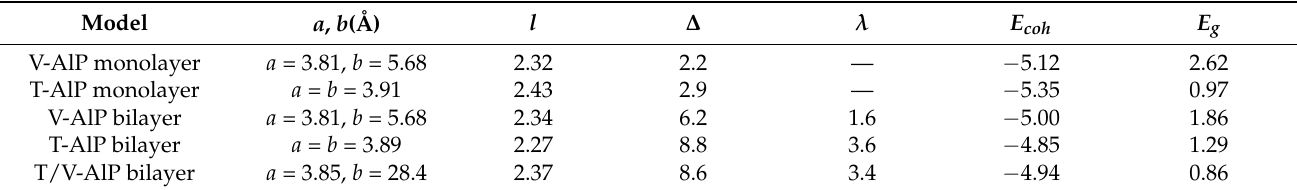
Figure 1. The geometry structures of ( a ) T-AlP; ( b ) V-AlP and ( c ) T/V-AlP bilayers. The two symbols a and b are lattice parameters. The symbols λ and ∆ represent vertical distances between the inner- and outer-layer atoms respectively. Table 1. The parameters of the 2D AlP crystals: lattice parameter ( a and b ), average bond lengths ( l ), cohesive energy ( E coh ) and band gap ( E g ). The unit of energy is electron volts (eV), and that of length is angstroms (Å). Thickness ∆ (Å) is defined by the vertical distance and it is shown in Figure 1. The distance λ (Å) between the upper layer and the lower layer is defined by the vertical distance between the lower- and upper-layer atoms in these 2D material models, as is also shown in Figure 1.